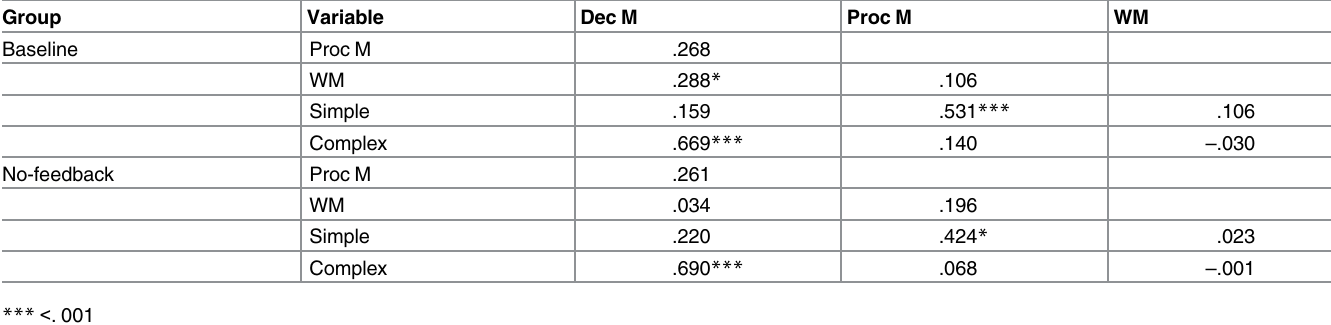
Table 4. Pearson correlations between the memory measures and learning of the simple and complex grammatical patterns by the baseline and no-feedback groups. Group